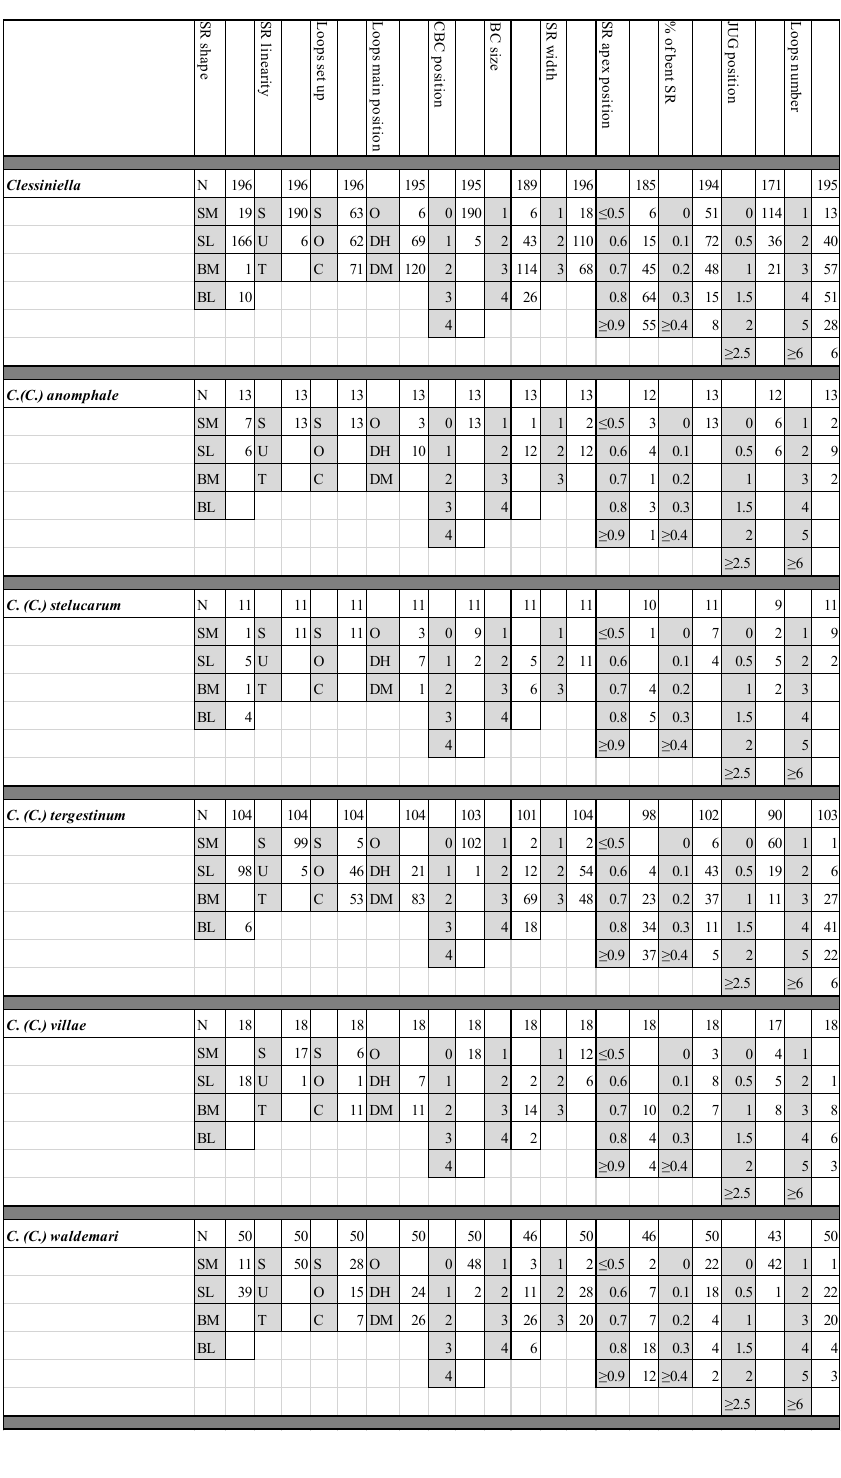
Table 4. Number of female specimens presenting the genital features as explained in Fig. 5. Abbreviation: N = number of analyzed